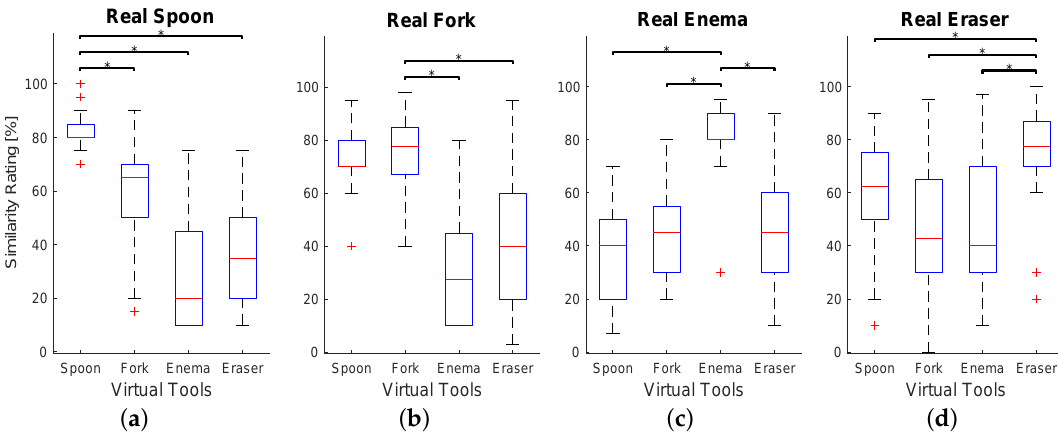
Figure 9. Similarity ratings between each real tool and all virtual tools. Asterisks indicates significant differences between conditions ( p < 0.05). ( a ) Similarity scores for real Spoon; ( b ) Similarity scores for real Fork; ( c ) Similarity scores for real Enema; ( d ) Similarity scores for real Eraser.